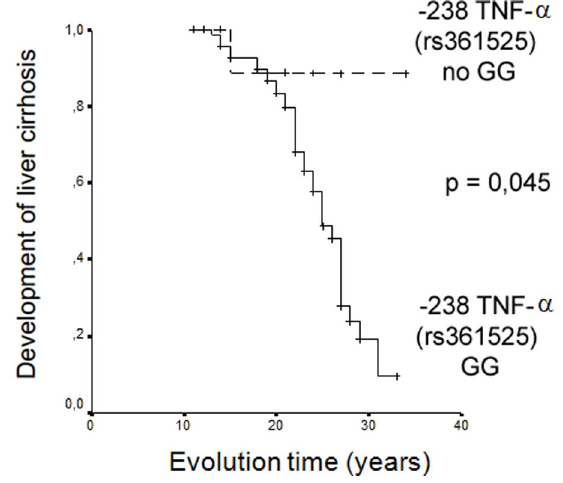
Figure 2. Kaplan Meier curves of the development of liver cirrosis in HIV-HCV patients in function of the polymorphism at -238 position of the TNF- a promoter gene. doi:10.1371/journal.pone.0066619.g002 PLOS ONE |